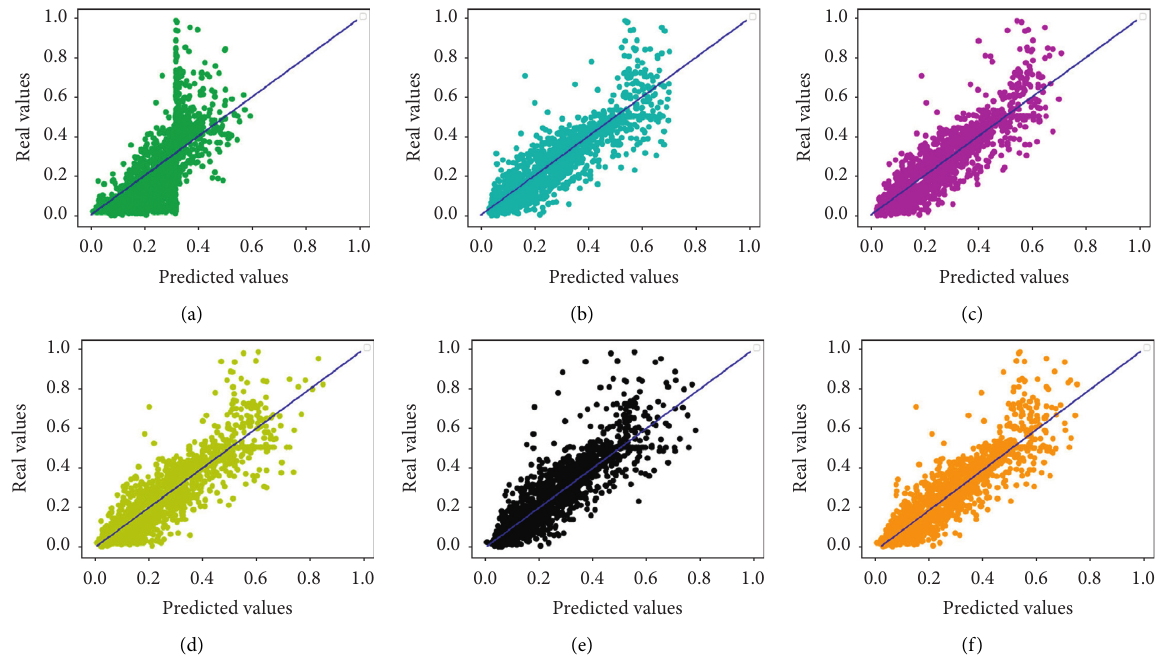
Figure 10: The scatter plot of the forecast and observed inflow for 3h lead times. (a) SVR, (b) DBN, (c) RFR, (d) GBRT, (e) LSTM, (f)